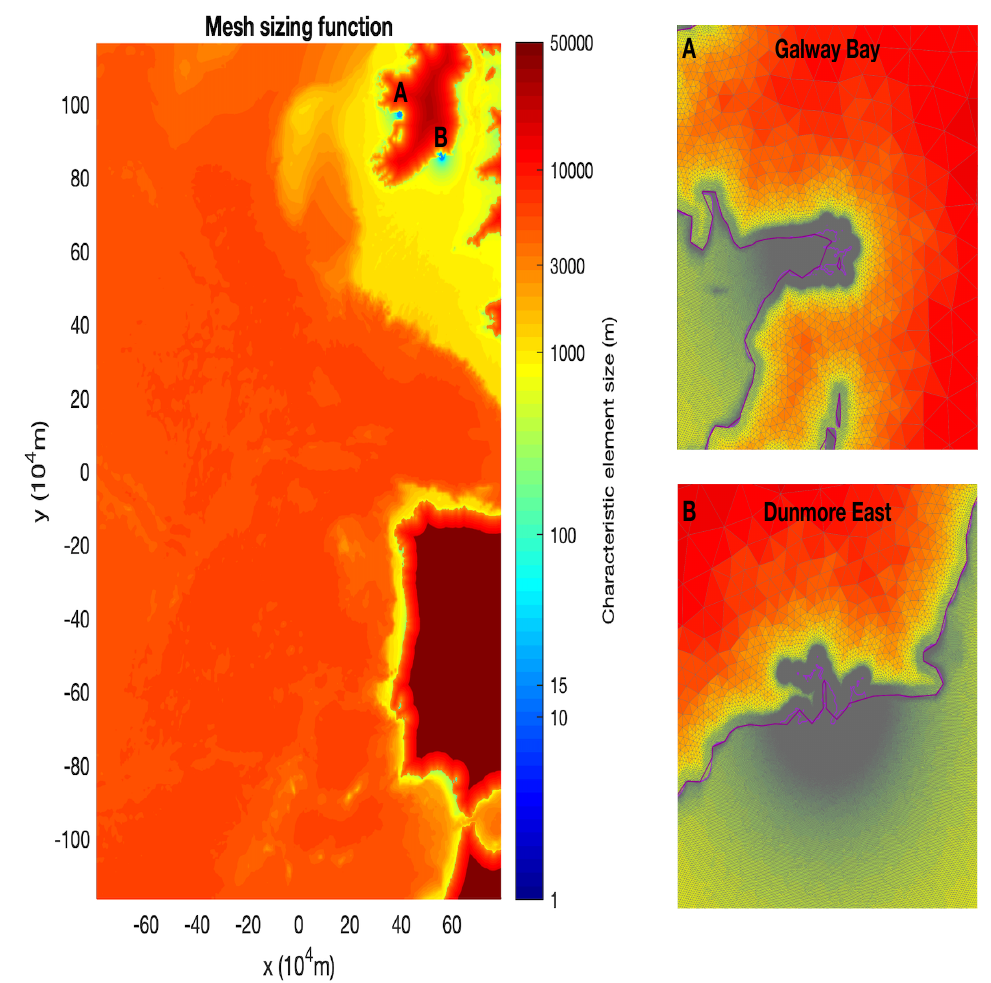
Figure 8. Left: Size of mesh triangles in the nonuniform unstructured mesh. The triangles with the minimum size (10 m) are concentrated around Galway Bay and Dunmore East. These areas are marked ( A , B ) respectively. Right: Zoom in on the high resolution mesh with the mesh triangles shown for, top: Galway Bay and bottom: Dunmore